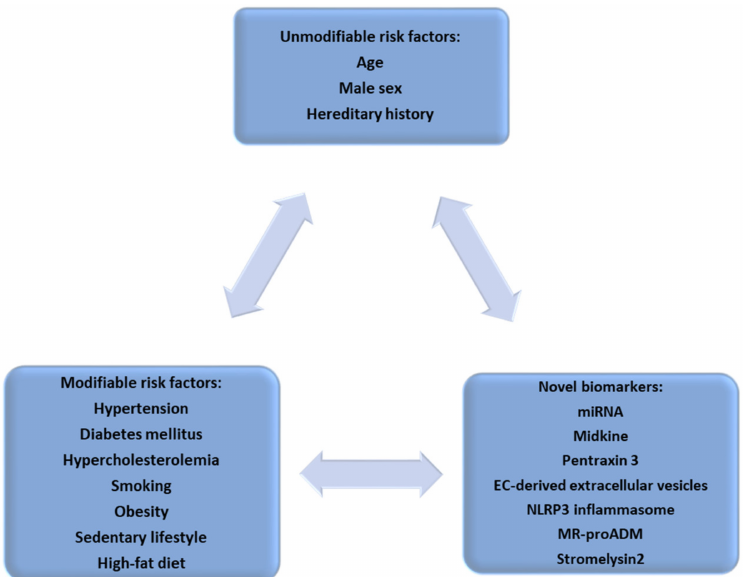
Figure 1. Risk factors associated with the occurrence of atherosclerotic vascular disease (EC: endothe- lial cell; MR-proADM: midregional pro-adrenomedullin; NLRP3: NOD-like receptor protein 3).